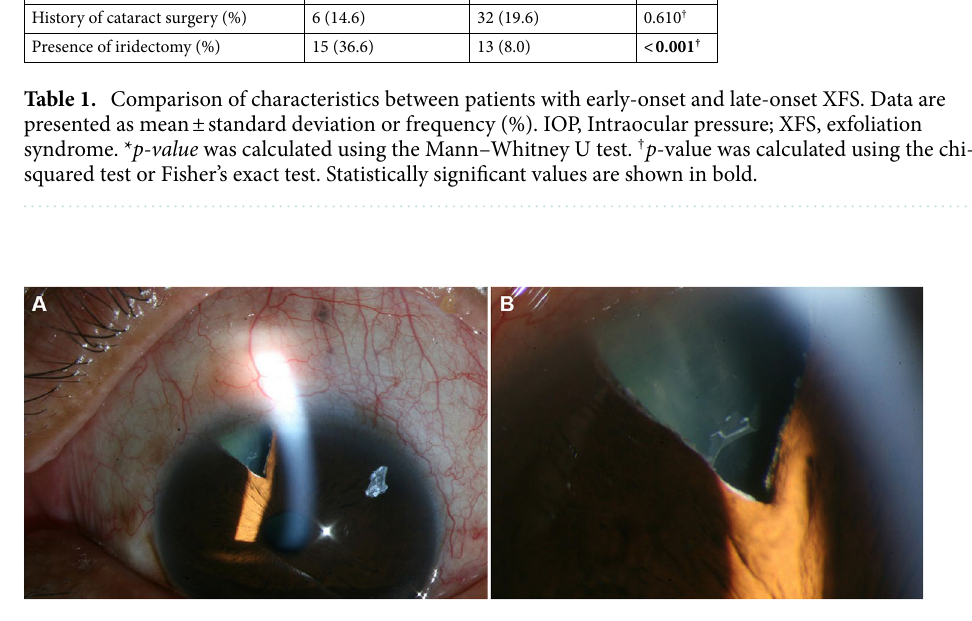
Figure 1. A case of early-onset exfoliation syndrome. The patient was diagnosed with primary open-angle glaucoma (POAG) in both eyes at the age of 51 years and underwent trabeculectomy in both eyes at the age of 54 years. At the age of 57 years, 3 years after surgery, exfoliation material was first noticed in the left eye. Typical exfoliation material is observed on the anterior surface of the lens capsule and at the iridectomy site ( A ). A magnification image of the iridectomy site ( B